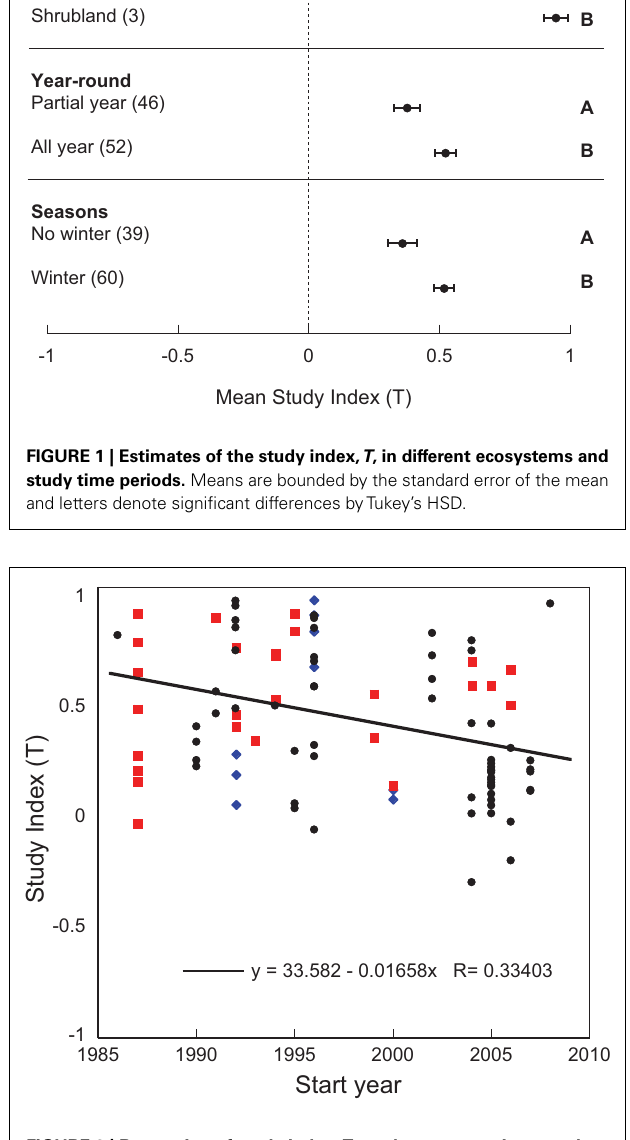
study was driven by the temperate region ( R 2 = 0.213, p <